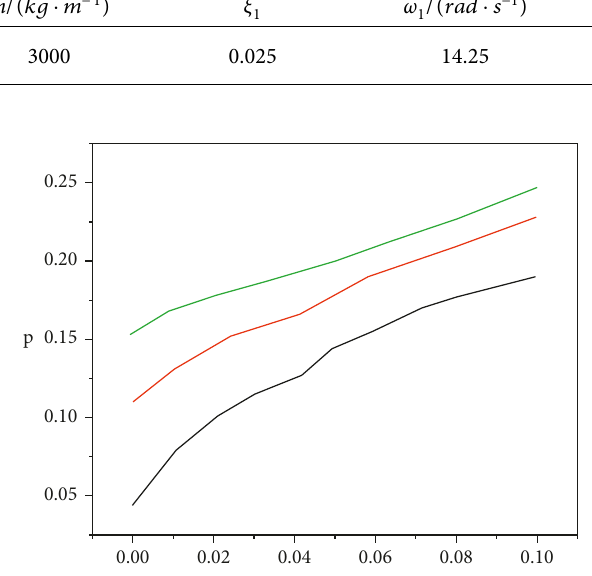
Figure 2: The influence of mass ratios μ and β on the optimal damping ratio of TMDI.